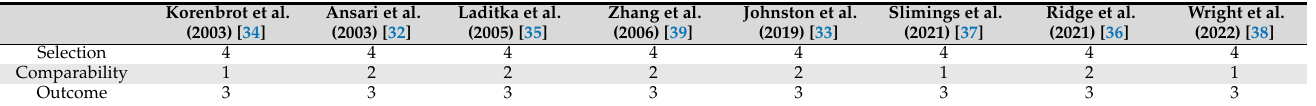
Table 3. Newcastle–Ottawa Scores for quantitative papers.